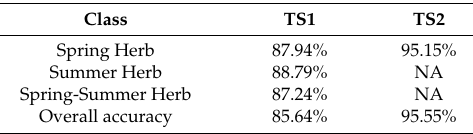
Table 5. User’s and overall accuracy of the Sentinel-2 data processing algorithm. Reference data for the ratio of correctly-classified pixels were acquired during field surveys at the test sites.